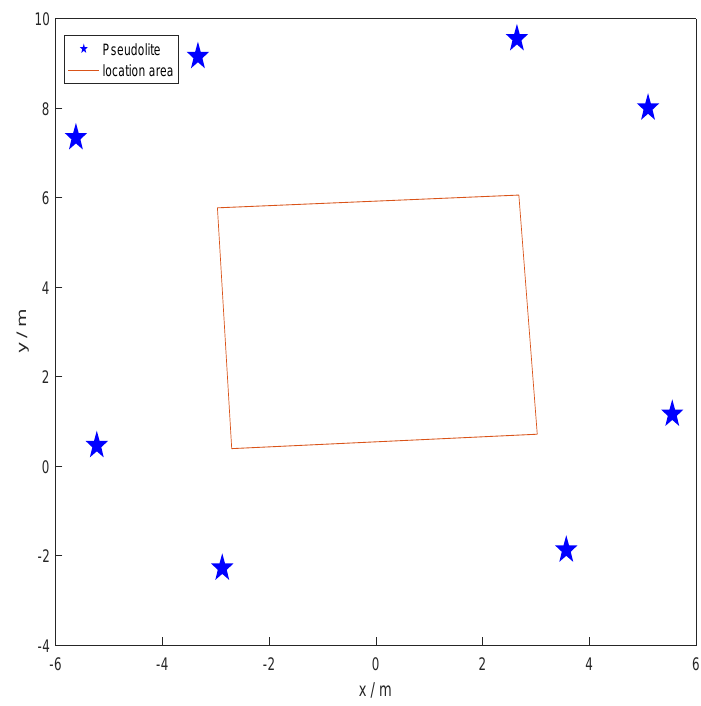
Figure 8. Pseudolite position